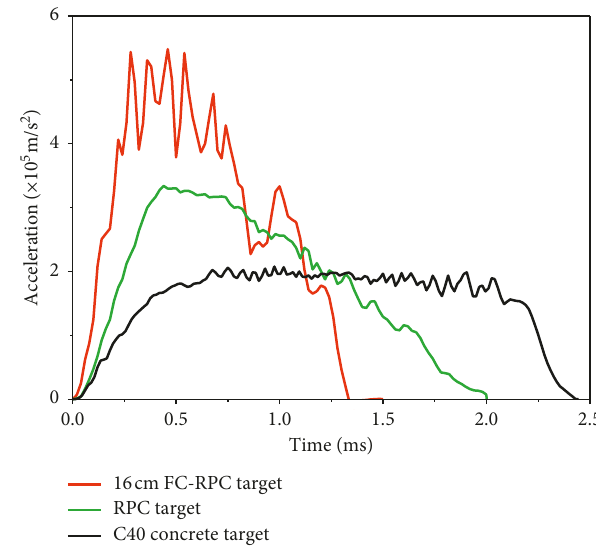
Figure 22: Acceleration time history curves of projectile pene- tration of different